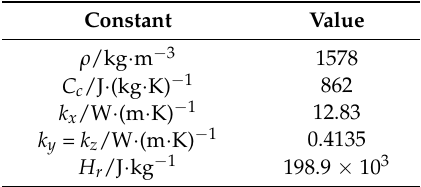
Table 1. Thermal parameters for the AS4/3501-6 prepreg [27].